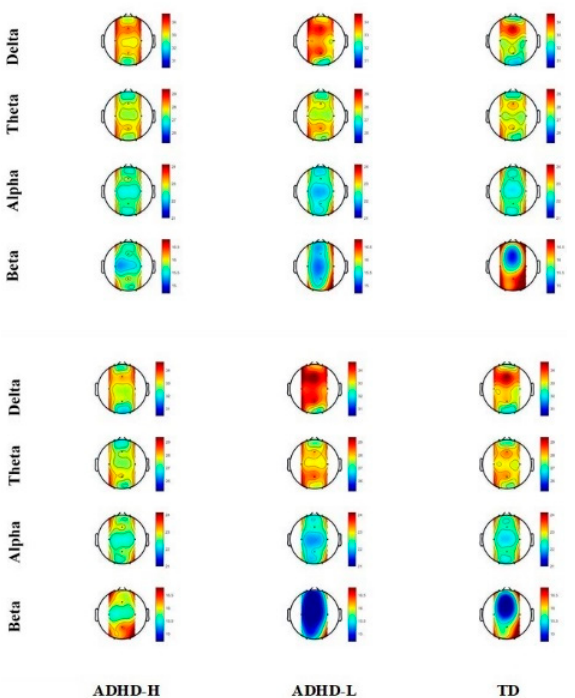
Figure 6. Topography of relative power in three conditions: rest ( upper ), slow-rate task ( middle ), and fast-rate task ( bottom ).